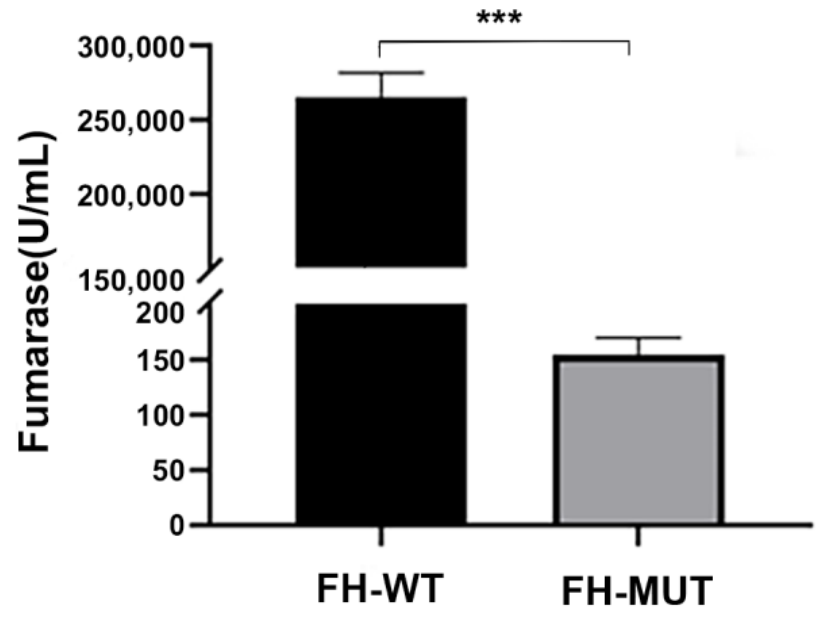
Figure 10. FH enzyme activity altered by E378K mutation. *** p < 0.001